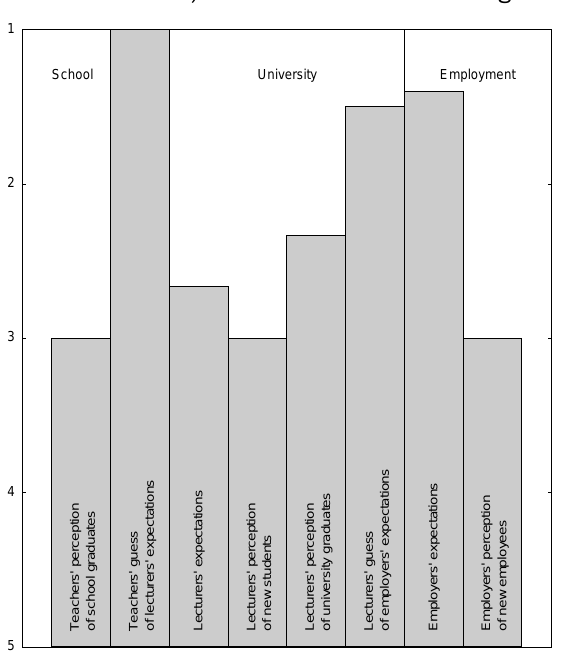
Figure 5. Expectations and perceptions for the competency “Ability to work and cooperate in a